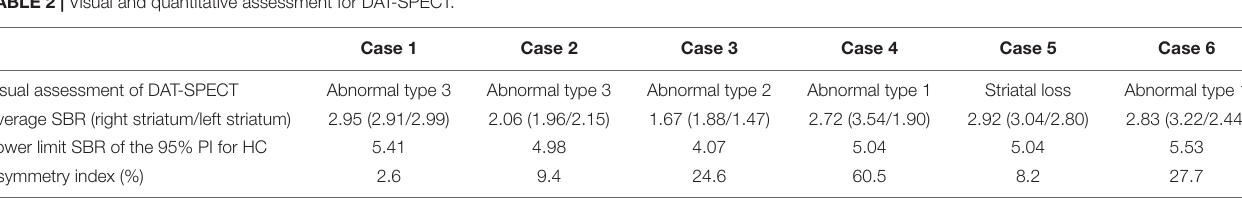
TABLE 2 | Visual and quantitative assessment for DAT-SPECT. Case 1 Case 2 Case 3 Case 4 Case 5 Case 6 Abnormal type 3 Abnormal type 2 Abnormal type 1 Striatal loss Abnormal type 1